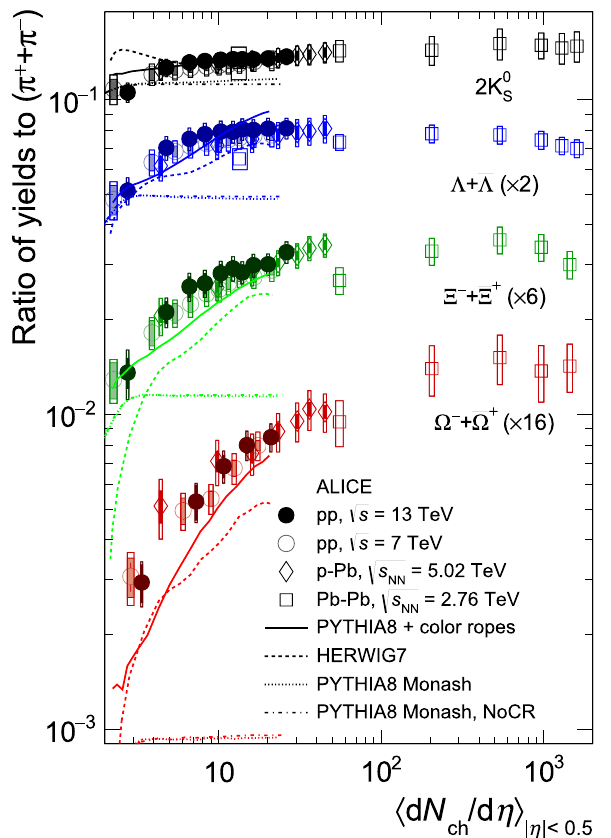
Fig. 6 Integrated strange hadron-to-pion ratios as a function of / d η (cid:5) measured in pp, p–Pb, and Pb–Pb collisions. The open (cid:4) d N ch (shaded)boxesaroundmarkersrepresentfull(multiplicityuncorrelated) systematic uncertainties. Different lines represent predictions from dif- √ s = 13 TeV. References ferent MC generators for pp collisions at from